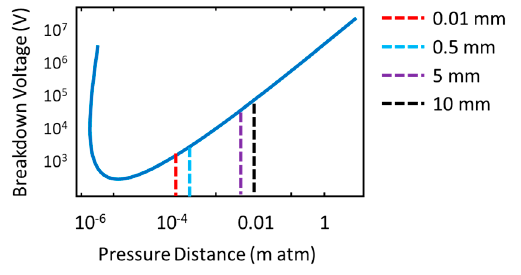
Figure 2. Paschen’s curve at varying electrode gap distances of 0.01 mm, 0.5 mm, 5 mm, 10